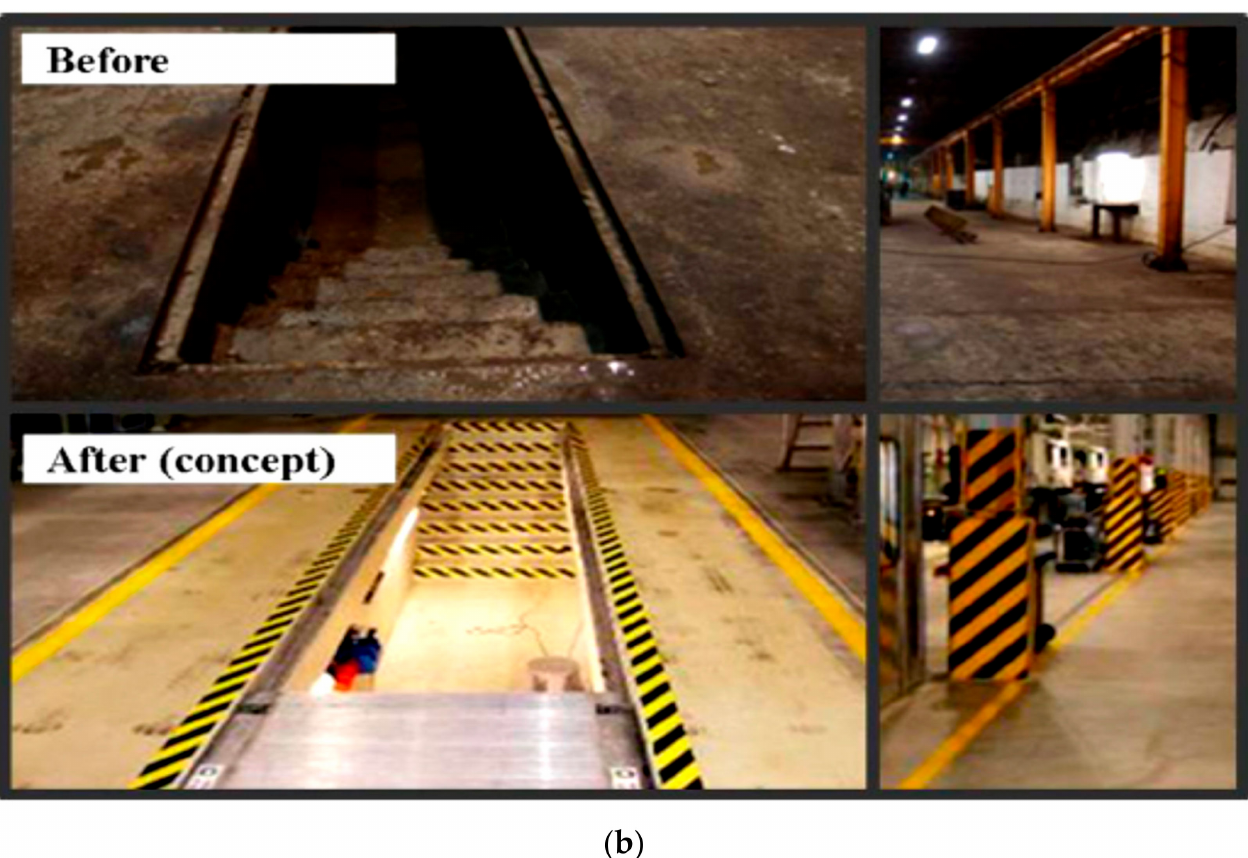
Figure 12. ( a ) Improvement in shop floor management (Choomlucksana et al. [59]). ( b ) Improvement on the shop floor (Chlebus et al.